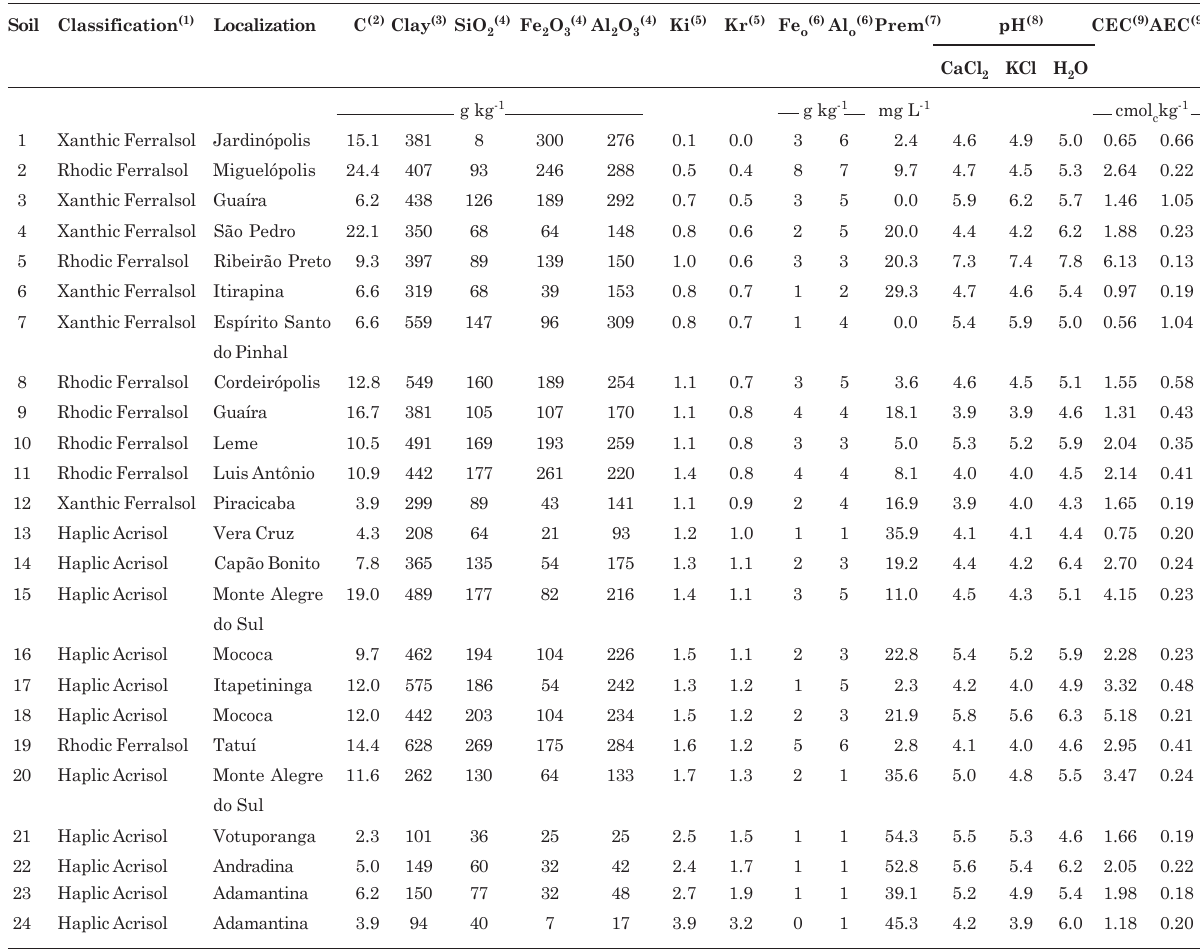
Table 1. Classification, localization and selected properties of the studied